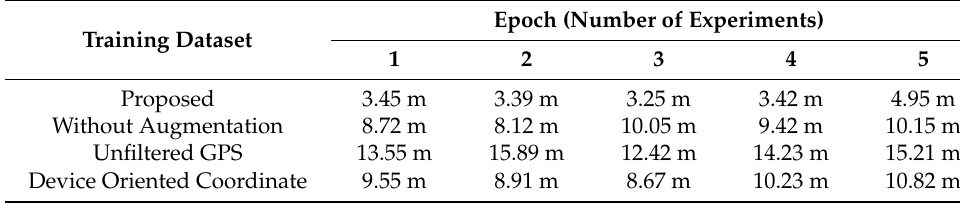
Table 5. Positioning error for each method at every